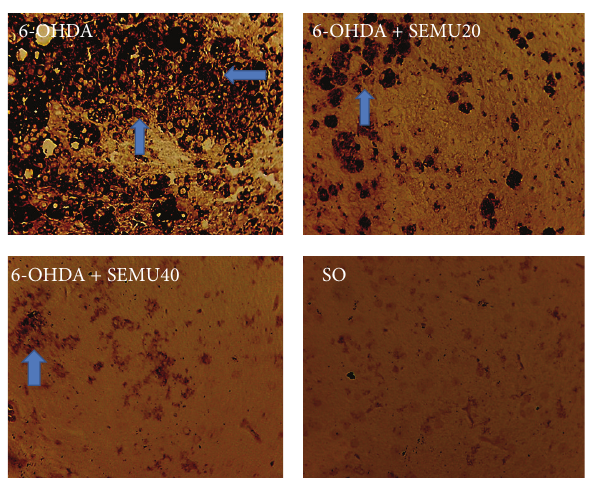
Figure 7: Immunohistochemistry for OX-42 (a marker for microglia), in the lesioned right striatum. A very high number of immunopositive cells are present in the untreated 6-OHDA group, as related to the 6-OHDA group after treatments with SEMU (20 and 40 mg/kg, p.o.). Almost no immunopositive cells were noticed in the SO group (magnification: 400x). Arrows indicate OX-42 immunopositive